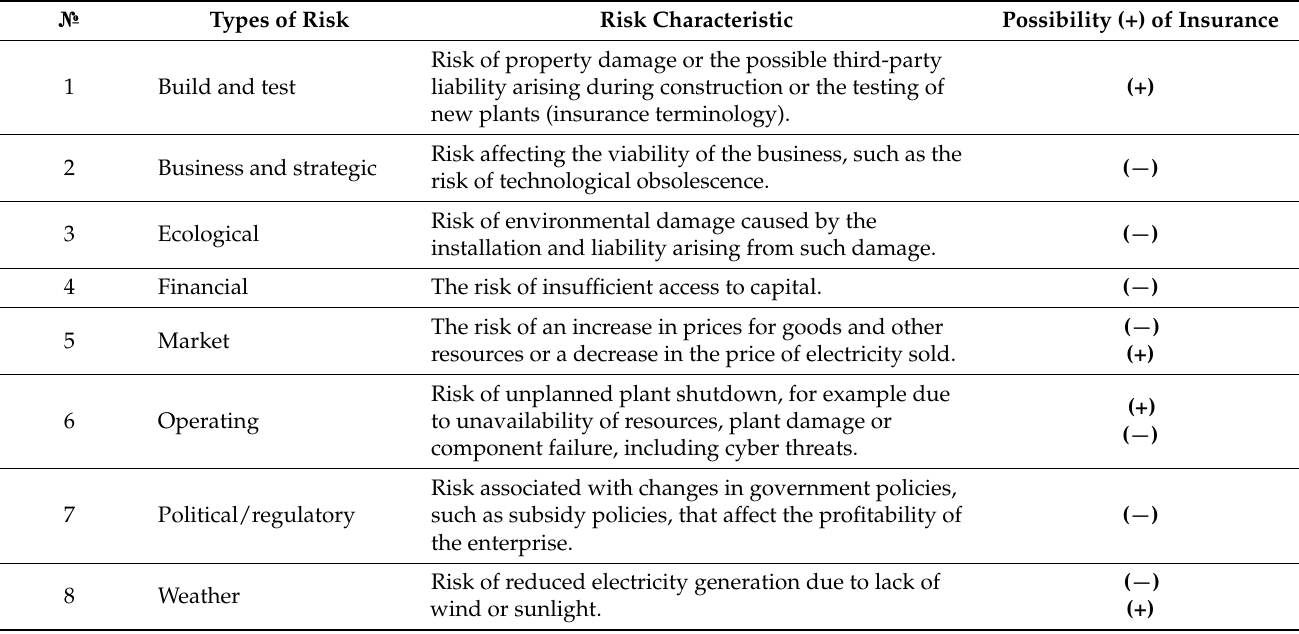
Table 1. Areas of risk associated with the construction and operation of renewable energy sources. № Types of Risk Risk Characteristic Possibility (+) of Insurance Risk of property damage or the possible third-party 1 Build and test liability arising during construction or the testing of new plants (insurance terminology). Risk affecting the viability of the business, such as the risk of technological obsolescence. Risk of environmental damage caused by the installation and liability arising from such damage. The risk of insufficient access to capital. The risk of an increase in prices for goods and other resources or a decrease in the price of electricity sold. Risk of unplanned plant shutdown, for example due to unavailability of resources, plant damage or component failure, including cyber threats. Risk associated with changes in government policies, such as subsidy policies, that affect the profitability of the